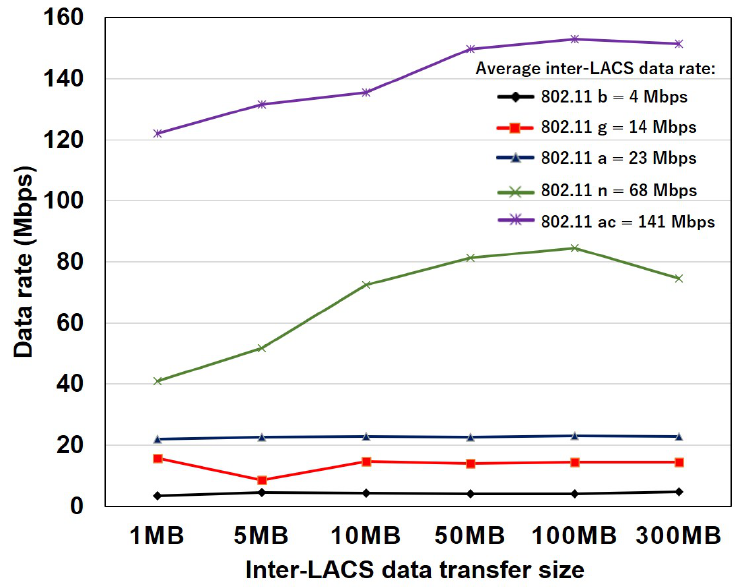
Figure 11. Inter-LACS data